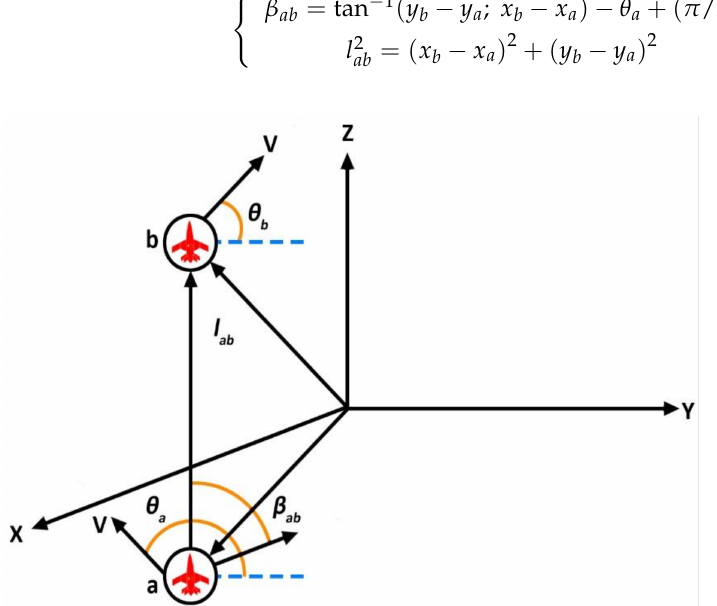
Figure 4. The configuration between two agents in a 3D environment revealing the relative distance and bearing between agent a and b